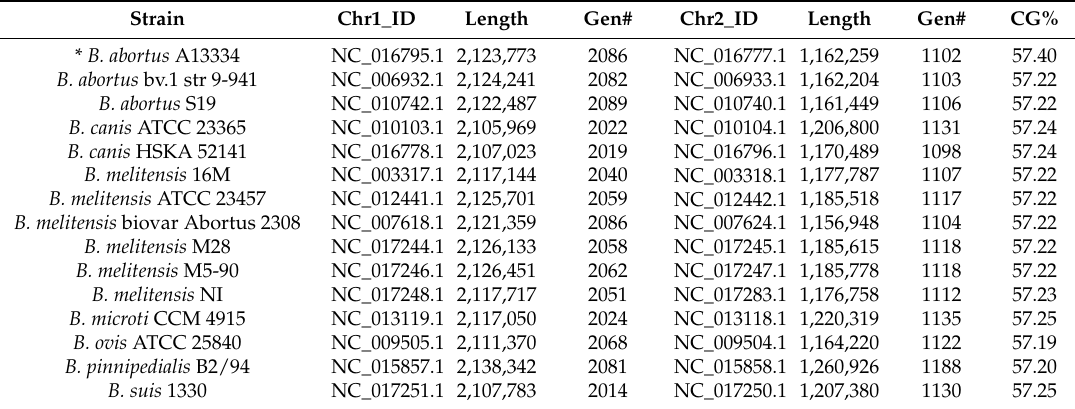
Table 1. 18 Brucella complete